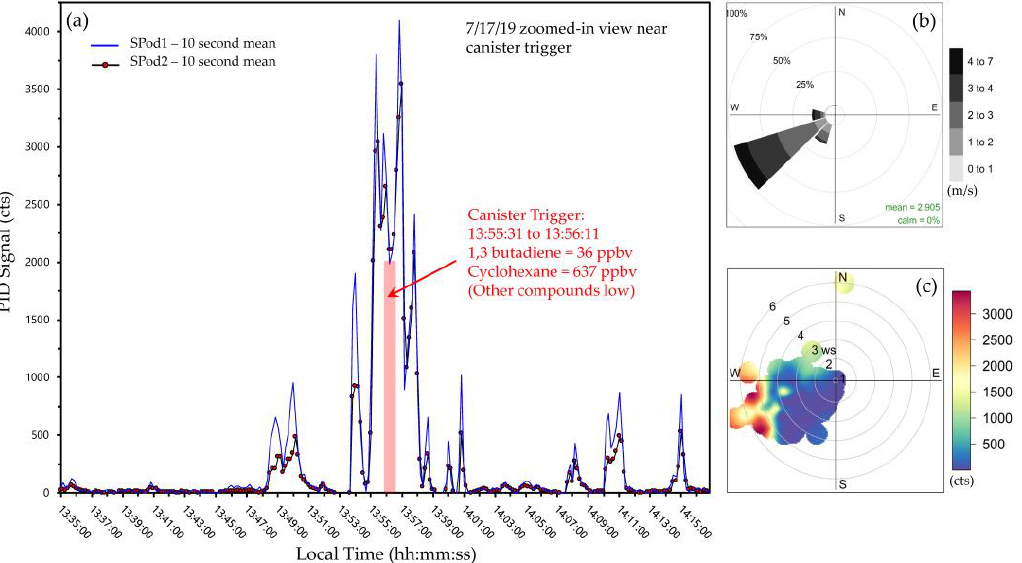
Figure 3. Example of collocated SPod data and canister trigger time frame on 7/17/19: ( a ) SPod1 (blue line) and SPod2 (red points trace) baseline-corrected 10 s average timeseries with canister trigger duration indicated by red rectangle and described in red text; ( b ) SPod1 and SPod2 combined wind rose; ( c ) SPod1 and SPod2 combined SDI plot showing the wind-resolved interpolated median concentration of PID signal.